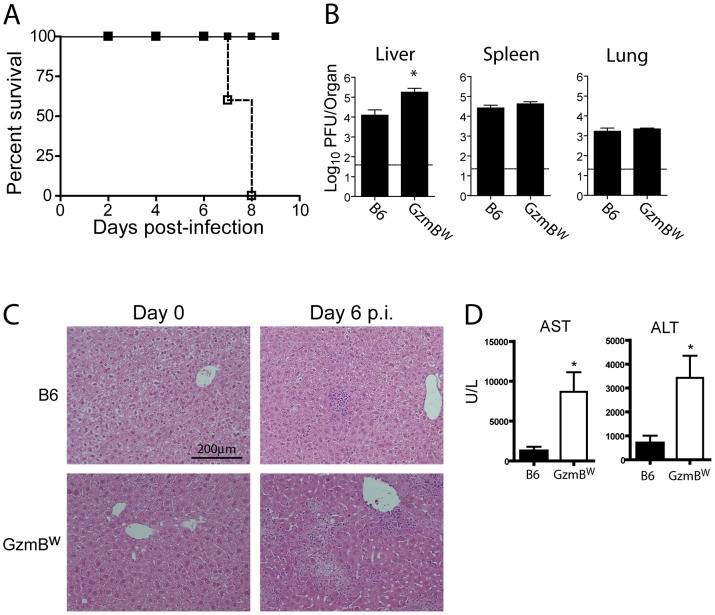
GzmBW/W mice are sensitive to infection with Δm157 MCMV.(A) B6 mice (black square) or GzmBW/W mice (white square) were infected with 2×104 pfu of MCMV Δm157 and survival monitored over the indicated time course (n = 5 for each group). ***P<0.0001. (B) The indicated mouse strains were infected with 2×104 pfu of MCMV Δm157, the indicated organs were removed at day 7 post-infection, and viral load quantified by plaque assay. Data are pooled from 2 independent experiments, mean ± SEM are plotted, where n≥8. *P<0.05. (C) Livers from uninfected or MCMV-infected mice were isolated at day 6 post-infection, fixed and tissue sections stained with haematoxylin and eosin. The results are representative of two independent experiments. (D) Liver enzymes in the serum of B6 mice (black bar) or GzmBW/W mice (white bar) were measured at day 6 post-infection. Data are pooled from two independent experiments where n≥5. *P<0.05.